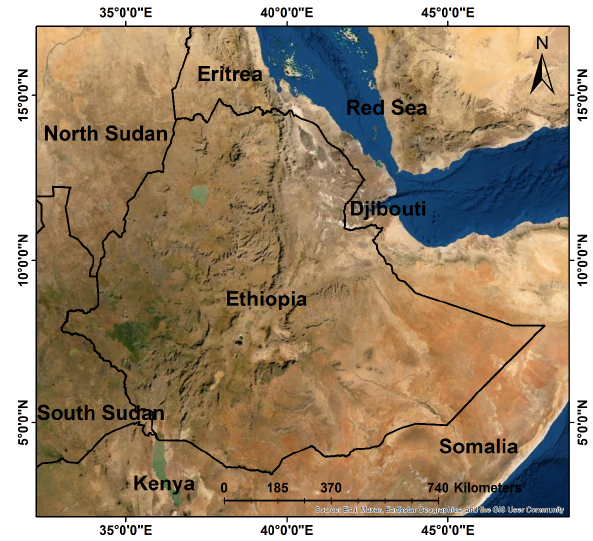
Figure 1. Ethiopia Map.